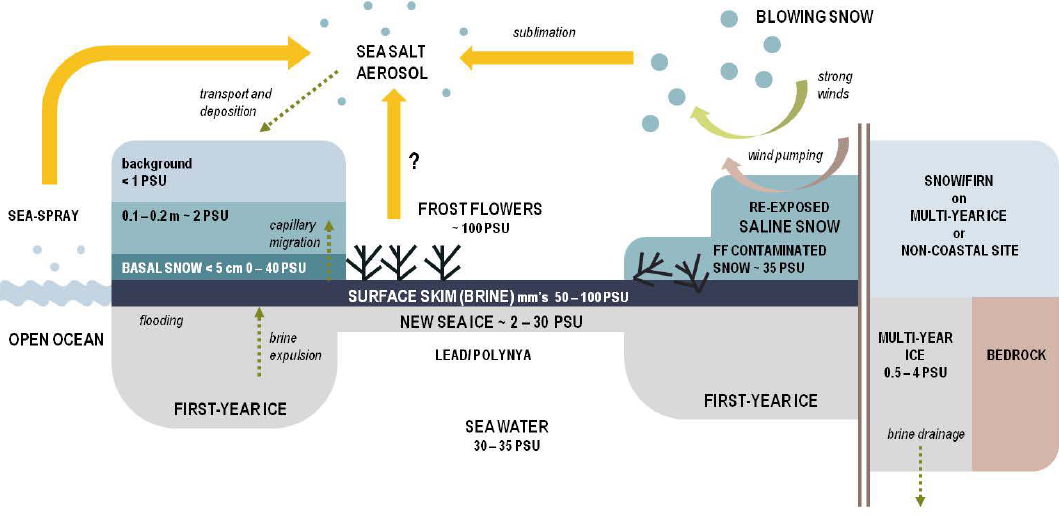
Fig. 1. Sources of halides in the polar boundary layer. A range of salinity values is indicated: frost flowers (Rankin et al., 2002), brine, new ice (Ehn et al., 2007), multi-year ice (Timco and Weeks, 2010), basal snow (Toyota et al., 2011b), snow < 0.2m (Toyota et al., 2011b), background snow (Massom et al., 2001), frost flower (FF) contaminated snow (Obbard et al.,